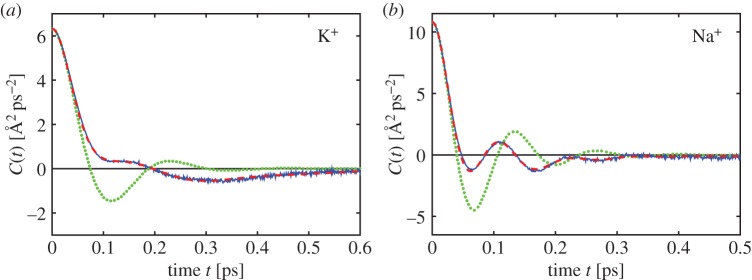
(a) Velocity autocorrelation function (7.8) calculated by the all-atom MD model of K+ ion (blue solid line), by the coarse-grained model (1.2)–(1.5) (green dotted line) and by the fictitious particle model (7.1)–(7.4) for N=3 (red dashed line), where the parameters of (7.1)–(7.4) are α1,1=5.64×102 ps−2, α1,2=73.8 ps−1, α1,3=3.42×103 ps−2, α1,4=80.9 Å ps−3/2, α2,1=1.26× 102 ps−2, α2,2=21.3 ps−1, α2,3=7.27×102 ps−2, α2,4= 3.43×10−1 Å ps−3/2, α3,1=72.1 ps−2, α3,2=2.02×102 ps−1, α3,3=3.26×10−1 ps−2 and α3,4=1.22× 102 Å ps−3/2. The parameters of the coarse-grained model (1.2)–(1.5) are given in table 3. (b) The same computations for Na+ ion, where the parameters of the fictitious particle model (7.1)–(7.4) are α1,1=3.05×103 ps−2, α1,2=3.08×102 ps−1, α1,3=8.99× 103 ps−2, α1,4=98.7 Å ps−3/2, α2,1= 96.5 ps−2, α2,2=2.48×102 ps−1, α2,3=4.62×102 ps−2, α2,4=15.8 Å ps−3/2, α3,1=23.5 ps−2, α3,2=25.5 ps−1, α3,3=3.82×102 ps−2 and α3,4=1.18×103 Å ps−3/2.